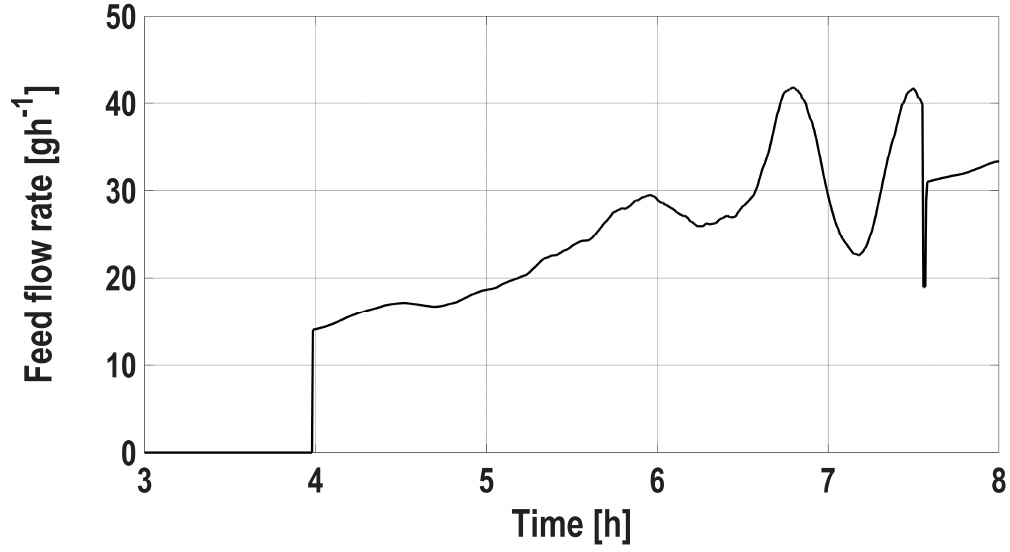
Figure 4. Feed flow rate applied during a controlled fed-batch culture, controller logic (Equation (8)).